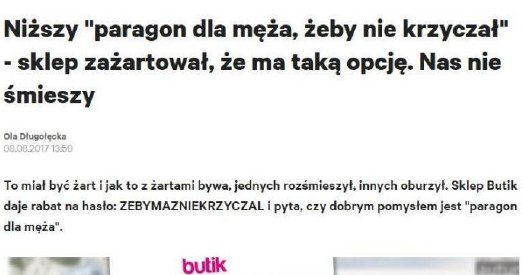
Figure 2. How to deceive your wife.